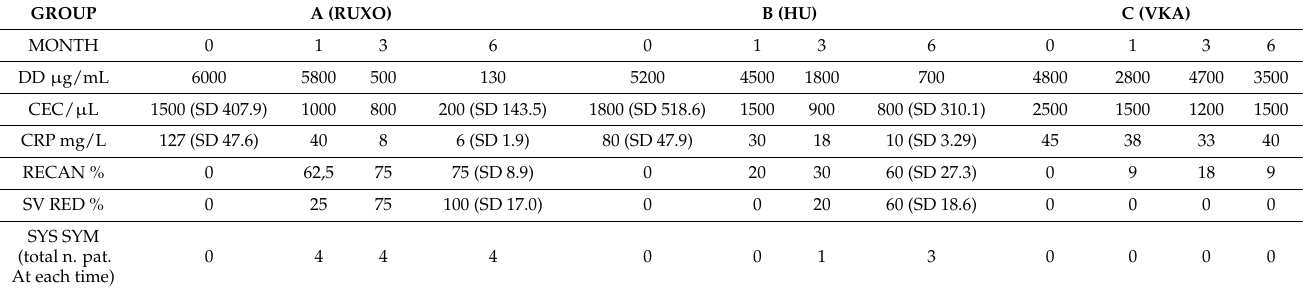
Table 2. Parameters observed during treatment (median values with standard deviations, SD).